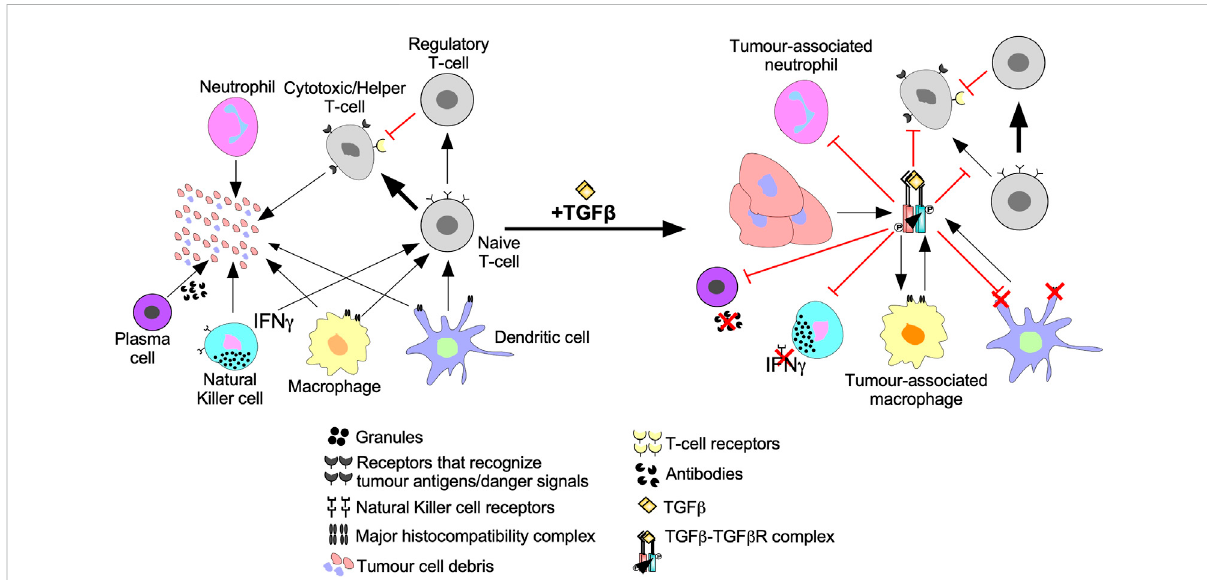
FIGURE 6 The inhibition of anti-cancer immune responses by TGF β . In the absence of immunosuppressive cytokines, cells of the innate and adaptive immune system destroy tumour cells as described in Figure 7. However, the addition of transforming growth factor- β (TGF β ) suppresses tumour recognition and cytotoxic functions of the innate and adaptive immune systems. For instance, TGF β suppresses antigen presenting function of macrophages, neutrophils, and dendritic cells by downregulation the major histocompatibility complex. TGF β decreases Natural Killer cell receptors, which spares tumour cells from Natural Killer cell-mediated destruction. TGF β dampens immune cell recruitment by disrupting interferon- γ (IFN γ ) production in Natural Killer cells, dendritic cells, and macrophages. TGF β induces macrophages and neutrophils to differentiate into tumour-associated macrophages and tumour-associated neutrophils, respectively, which augment tumourigenesis. TGF β disrupts B-cell differentiation into plasma cells and attenuates antibody production. TGF β also alters Naive T-cell differentiation to favour tumour promoting Regulatory T-cells instead of Cytotoxic T-cells or Helper T-cells that mediate tumour cell destruction. Regulatory T-cells promote tumourigenesis by suppressing Cytotoxic T-cell